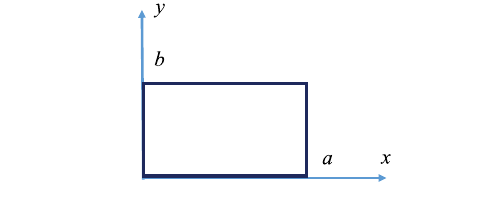
FIG. 1. An example of the exam problem about the energy eigenfunction.